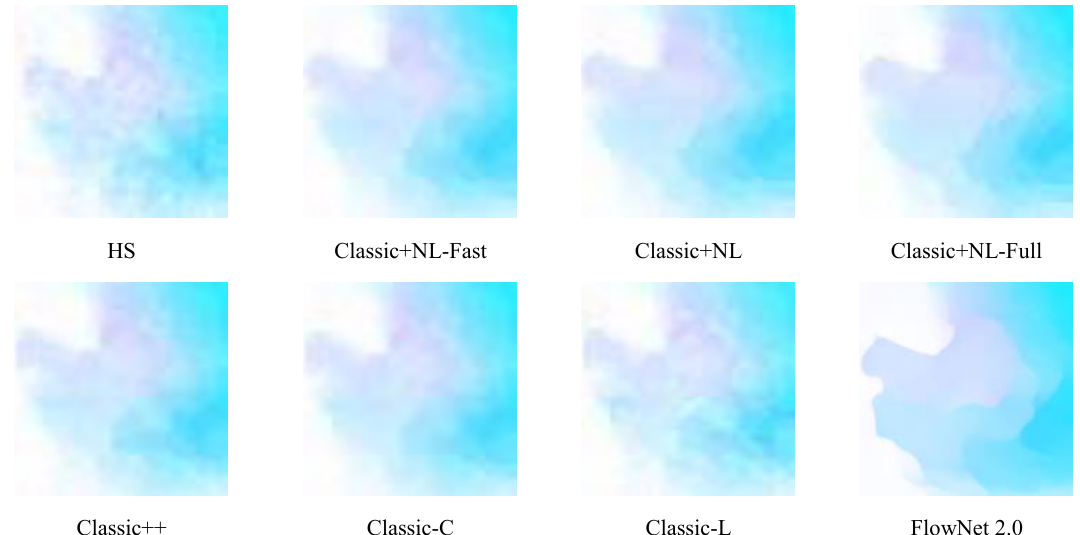
Figure 4. Zoom-in areas of the initial optical flow fields based on the red box in Figure 3(a)